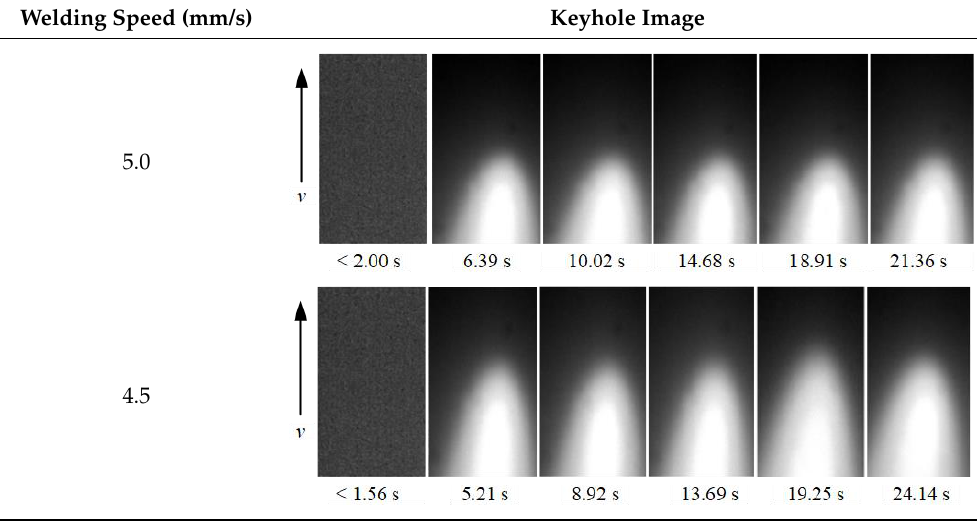
Table 2. Keyhole image on the back of the workpiece under different welding speeds.